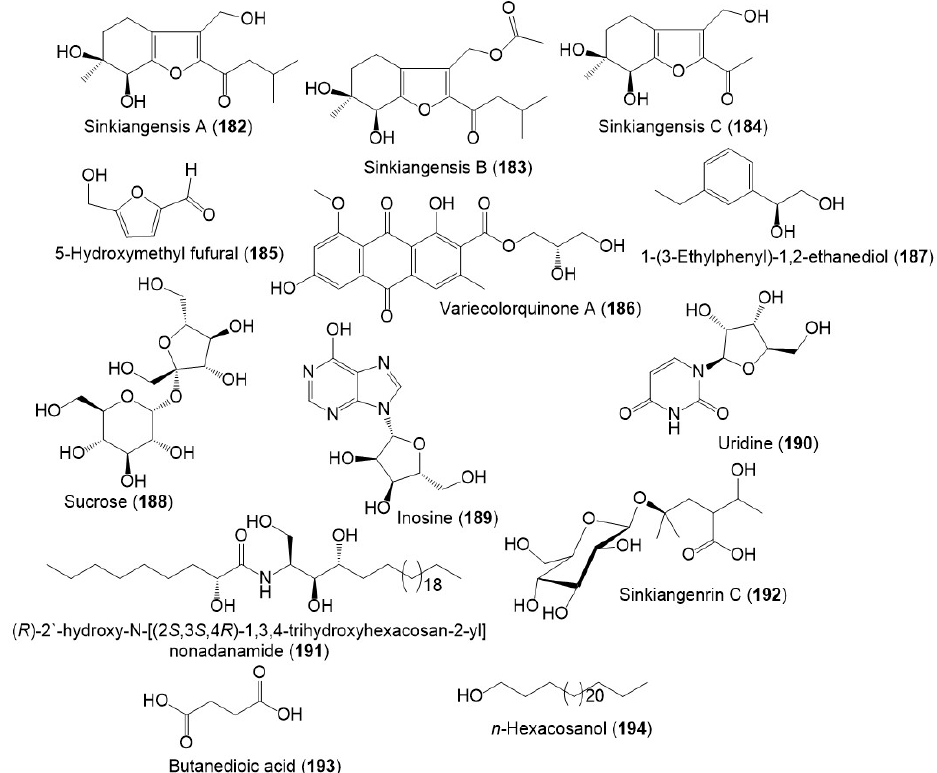
Figure 20. Structures of other metabolites ( 182 – 194 ) reported from F. sinkiangensis .